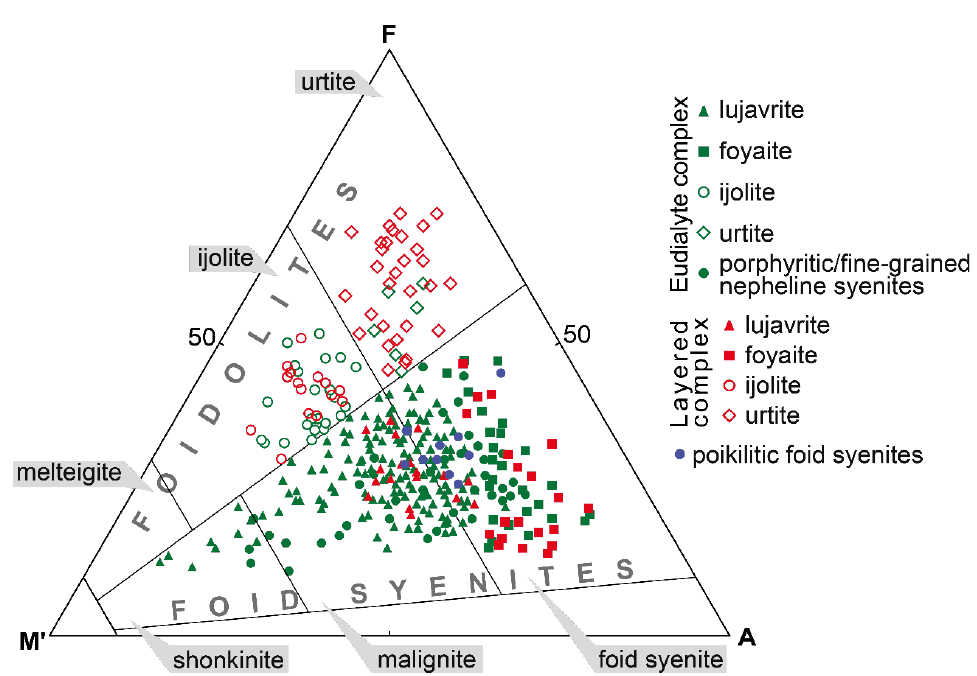
Figure 2. Modal composition and rock names of the alkaline rocks of the Lovozero massif. A —alkali feldspar, F —foid, M’ —color index (sum of mafic minerals minus muscovite, apatite, primary carbonates). The AFM’ triangle fields contain rock names accepted by the IUGS.